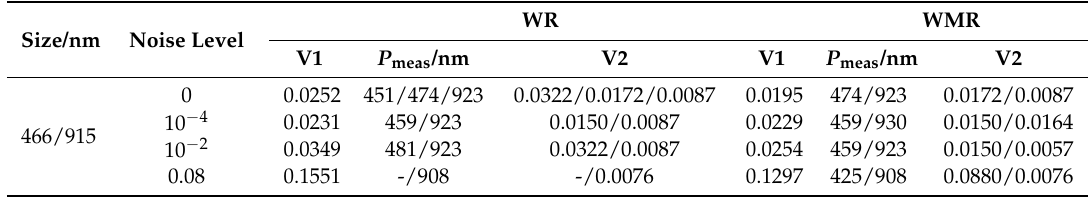
Figure 3. The inversion results with WR and WMR from 324/601/871 nm trimodal simulated DLS data under different noise levels: ( a ) noise level is 0; ( b ) noise level is 10 − 4 ; ( c ) noise level is 10 − 2 ; ( d ) noise level is 0.08. Table 2. The performance indices of the inversion for simulated 466/915 nm bimodal DLS data under different noise levels. Table 1. Parameters of simulated polydisperse PSD data sets.